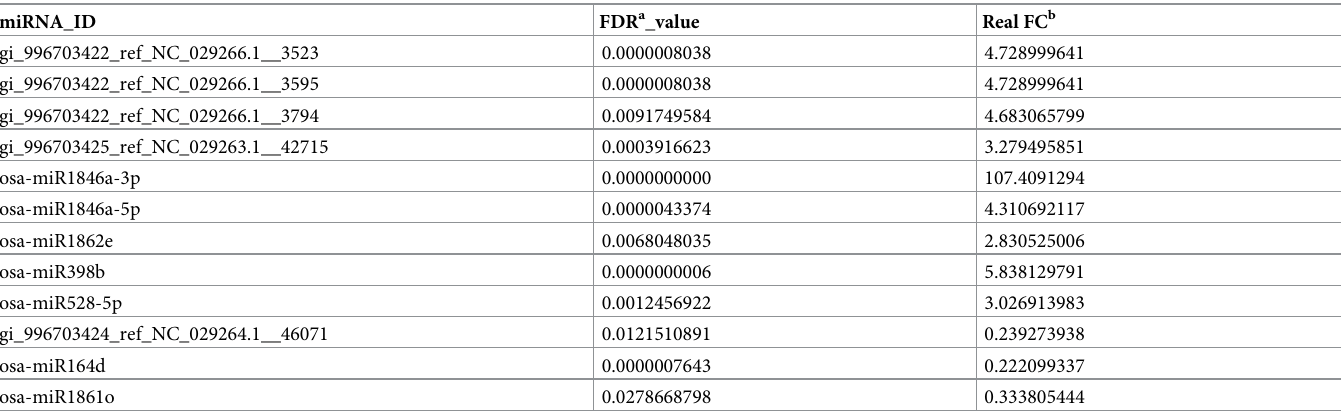
Table 1. Significantly differently expressed miRNAs in rice seed of 9311-4x versus